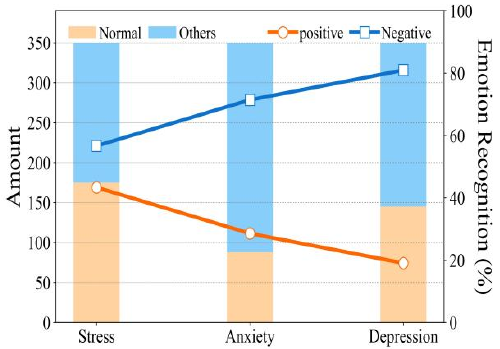
Figure 5. Correspondence map between facial emotion recognition and mental health score.